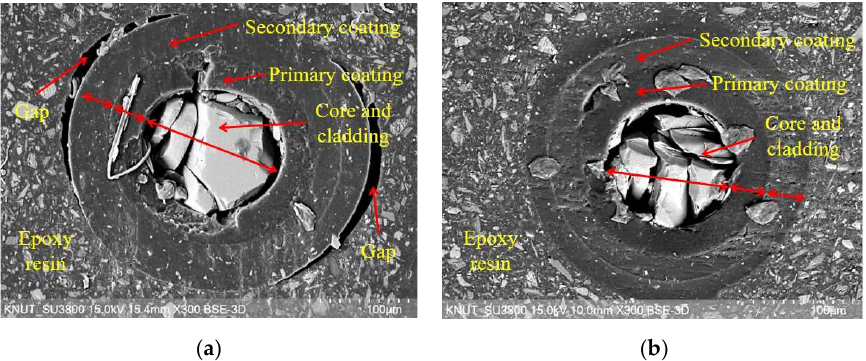
Figure 21. Scanning electron microscope images of FBG sensors in the E specimen: ( a ) Bond length of 80 mm and ( b ) Bond length of 150